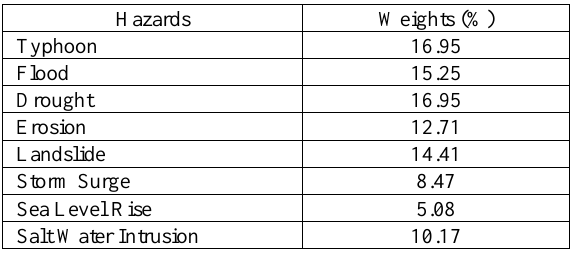
Table 4. Hazard weights used in the province of Agusan del